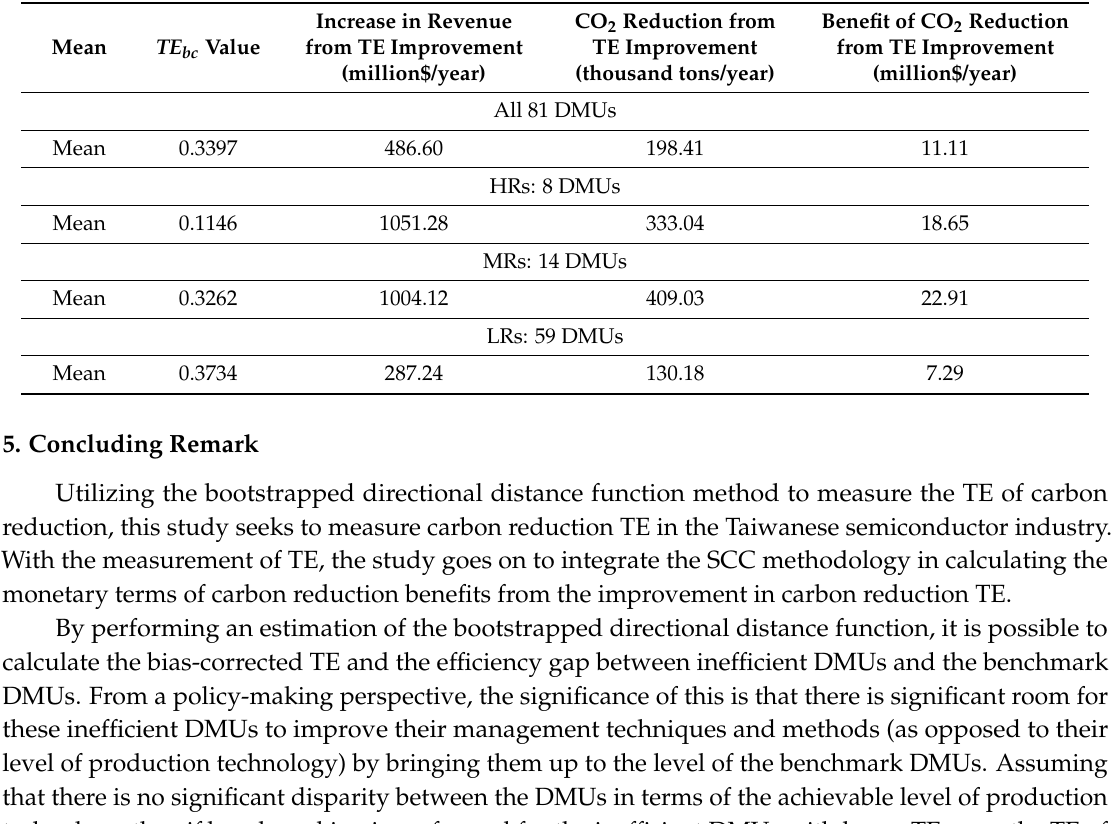
Table 4. Summary of Adjusted TE Simulation